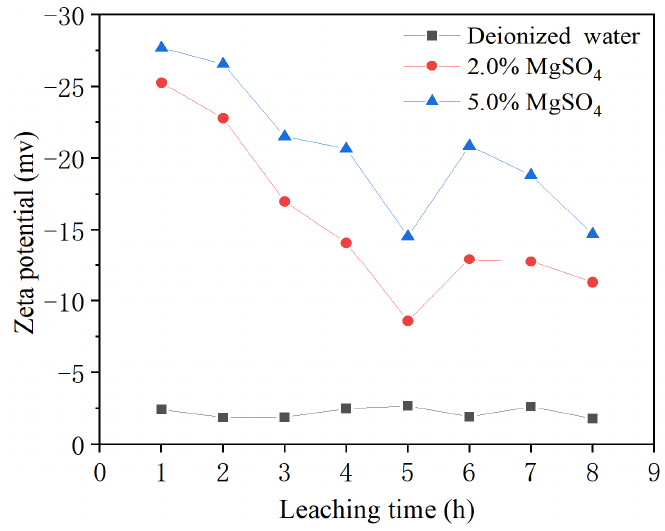
Figure 4. Variation of Zeta potential on the surface of RE particles in different concentrations of MgSO 4 and DI water leaching solution with leaching time.